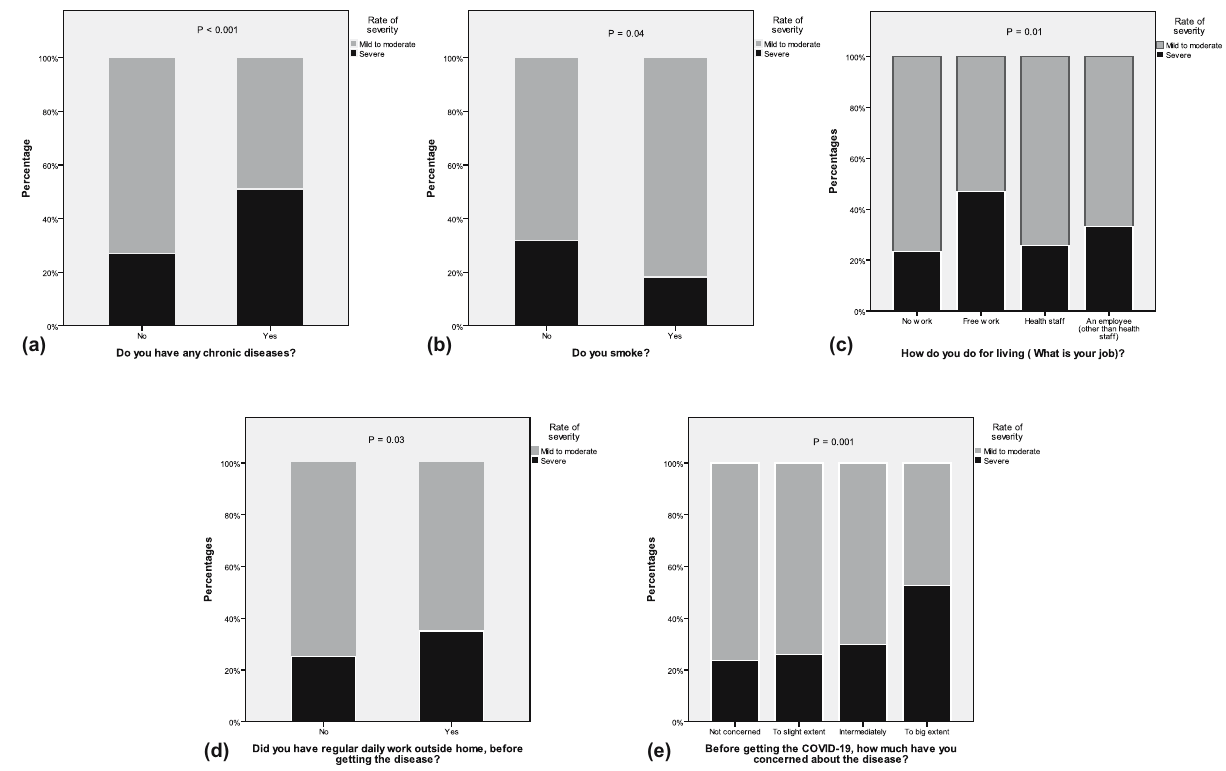
Figure 4: Comparison of the disease severity rating between ( a ) patients with and without comorbidities, ( b ) smokers and non - smokers, ( c ) patients with di ff erent jobs ( d ) patients with the presence or absence of regular daily work outside the home, and ( e ) patients with di ff erent degrees of concern about COVID - 19.